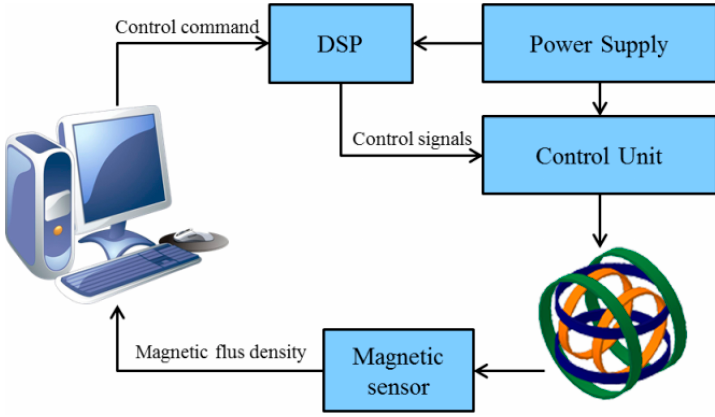
Figure 8. Schematic diagram of the measurement system.